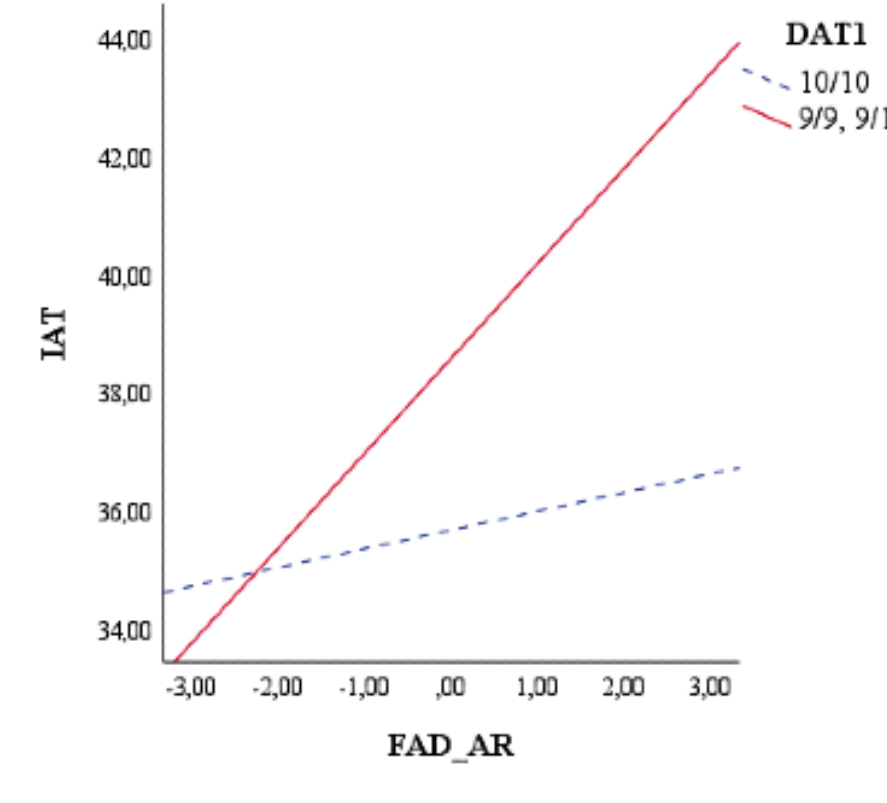
Figure 5. Moderation of youth’s DAT1 genotype on the relationship between the youth’s family functioning and IAT score. DAT: dopamine active transporter; FAD_AR: Family Assessment Device Affective Responsiveness; IAT: internet addiction